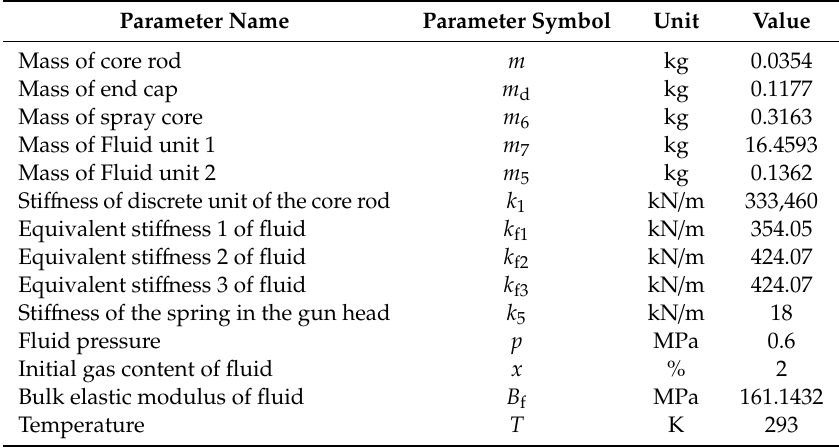
Table 2. Design parameters of the jet system.